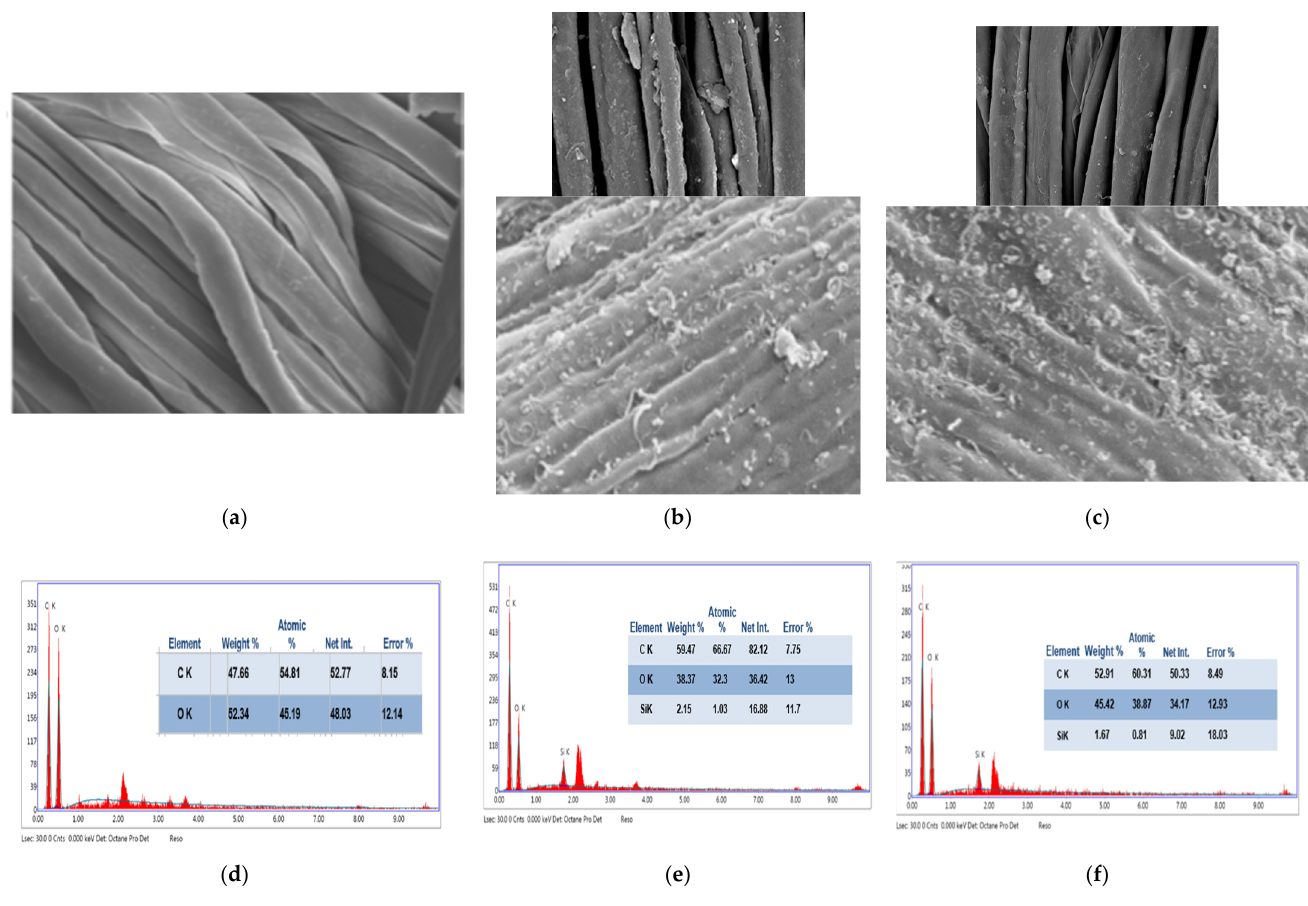
Figure 3. SEM images and EDX analysis of the treated and untreated cotton fabric. ( a ) SEM for